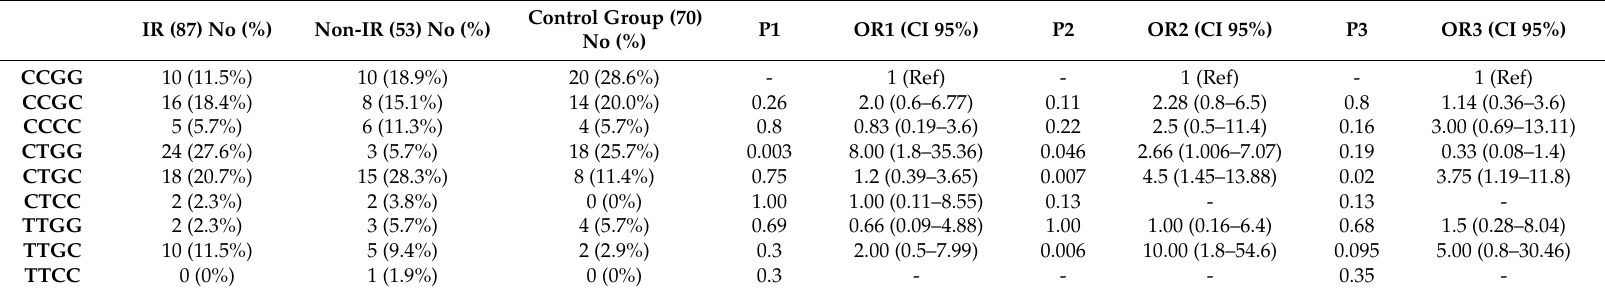
Table 4. Haplotyping analysis of c.1254 C > T and c.1517 G > C of XRCC1 gene polymorphisms in IR, non-IR and control